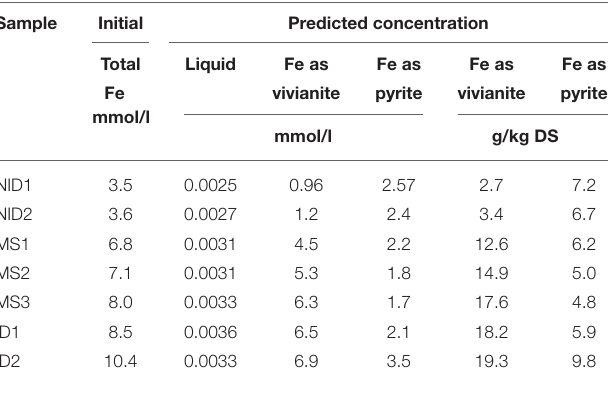
TABLE 4 | Predicted iron speciation from Phreeqc’s simulation.